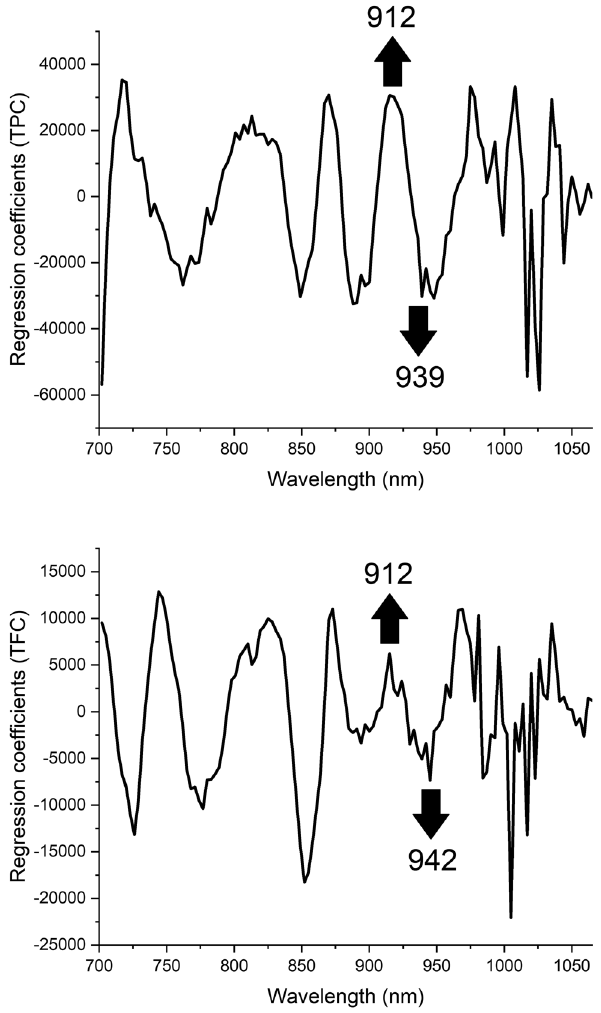
Figure 3: The regression coe ffi cient of a machine learning model for predicting total phenolic ( TPC ) and fl avonoid content ( TFC )